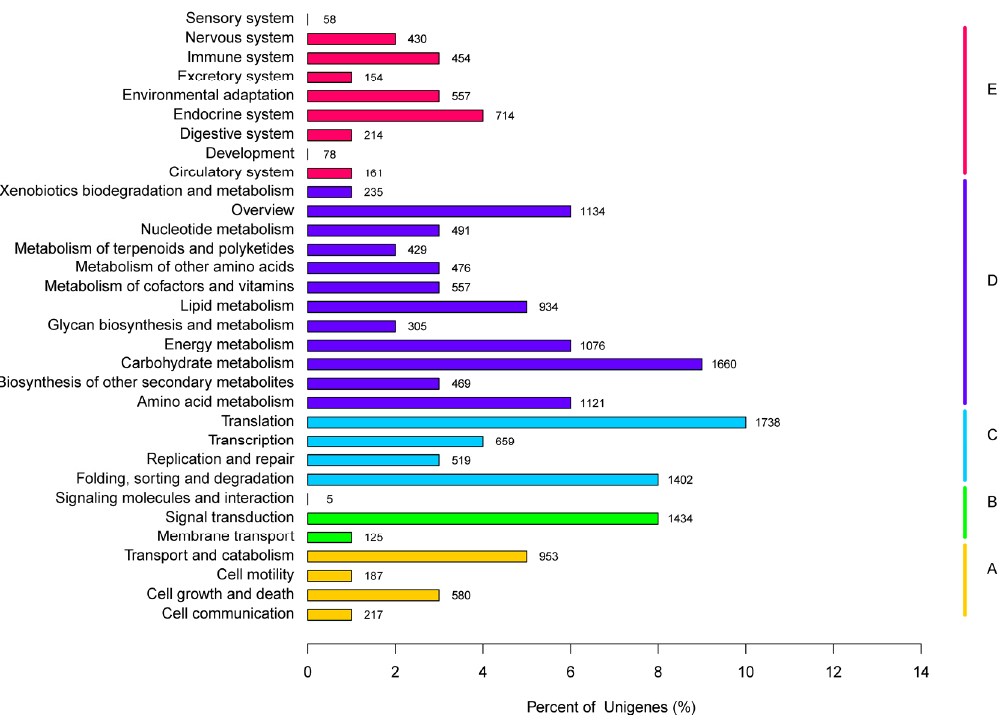
Figure 4. Pathway assignment based on the Kyoto Encyclopedia of Genes and Genomes (KEGG). (A) Classification based on cellular process categories; (B) classification based on environmental information processing categories; (C) classification based on genetic information processing categories; (D) classification based on metabolism categories; (E) classification based on organismal systems categories.